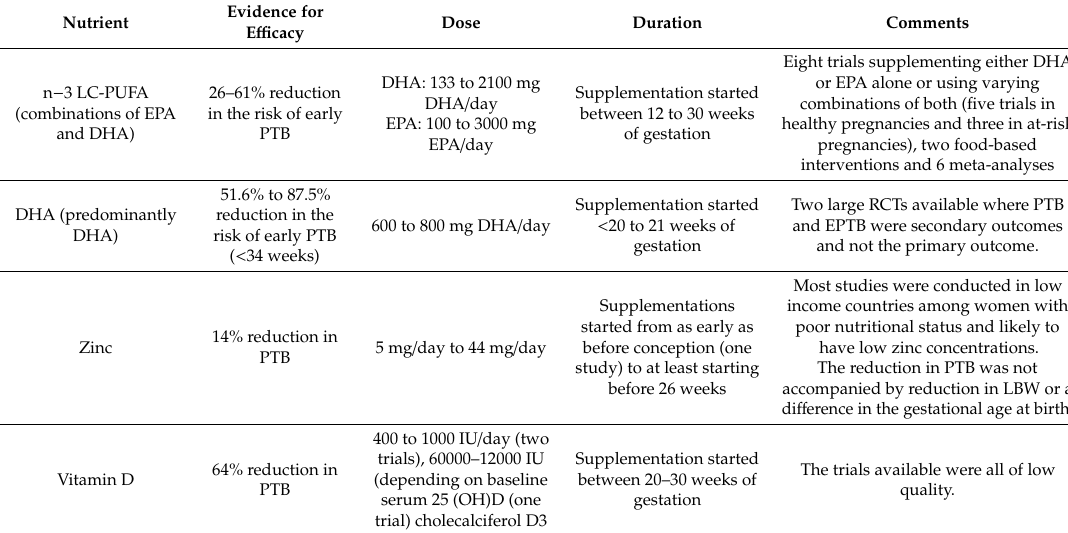
Table 3. Nutrients with known e ffi cacy to reduce the risk of